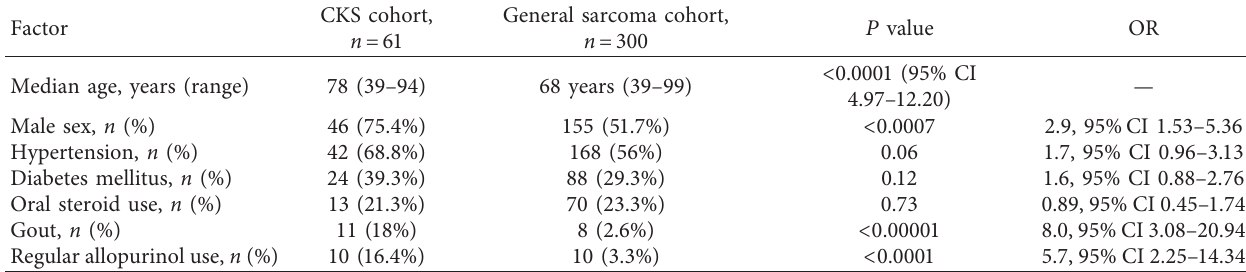
Table 1: Patients’ characteristics, n �